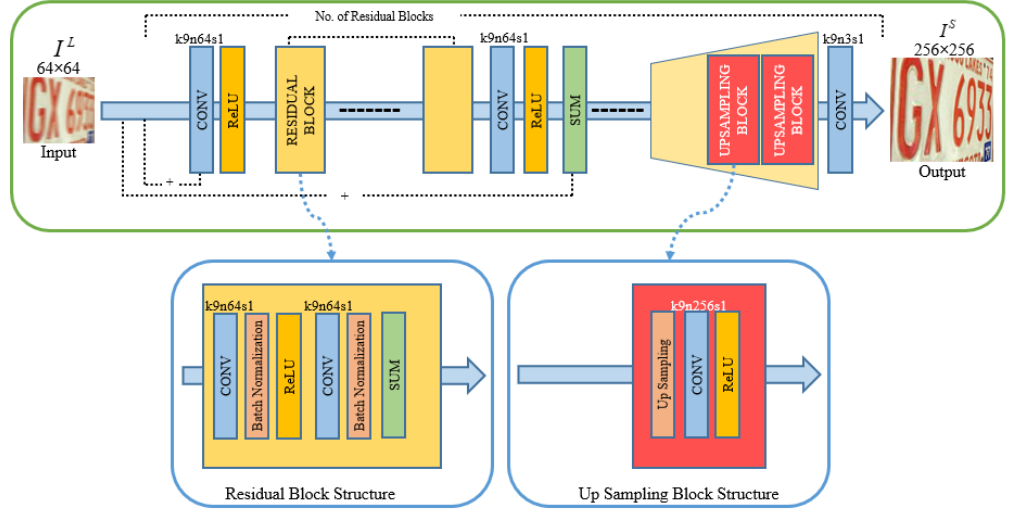
Figure 2. Architecture of the generator network. “k” represents filter size, “n” is the number of filters, and “s” is the stride value used in a particular layer. Two types of convolutional blocks are used in the generator. A “residual block” is used for feature extraction, whereas the “UpSampling” block is used for converting an image from I S to I H